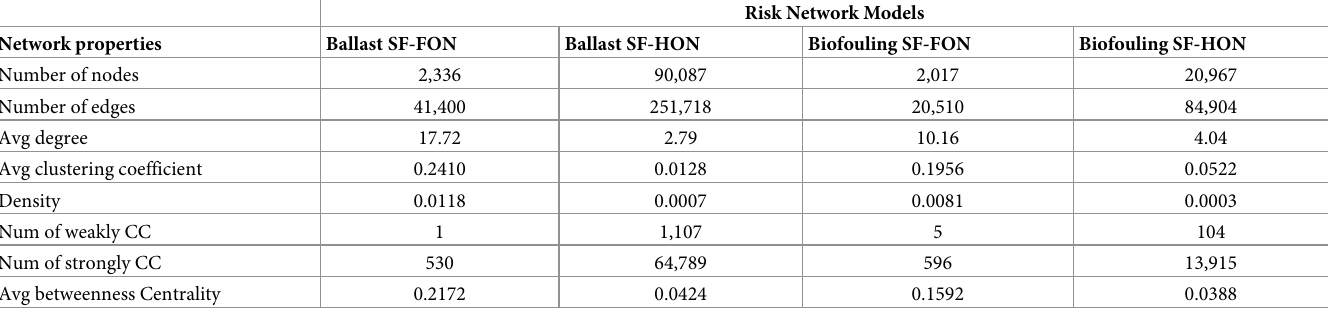
Table 1. Comparison of basic properties of the four networks. CC refers to the connected components of the